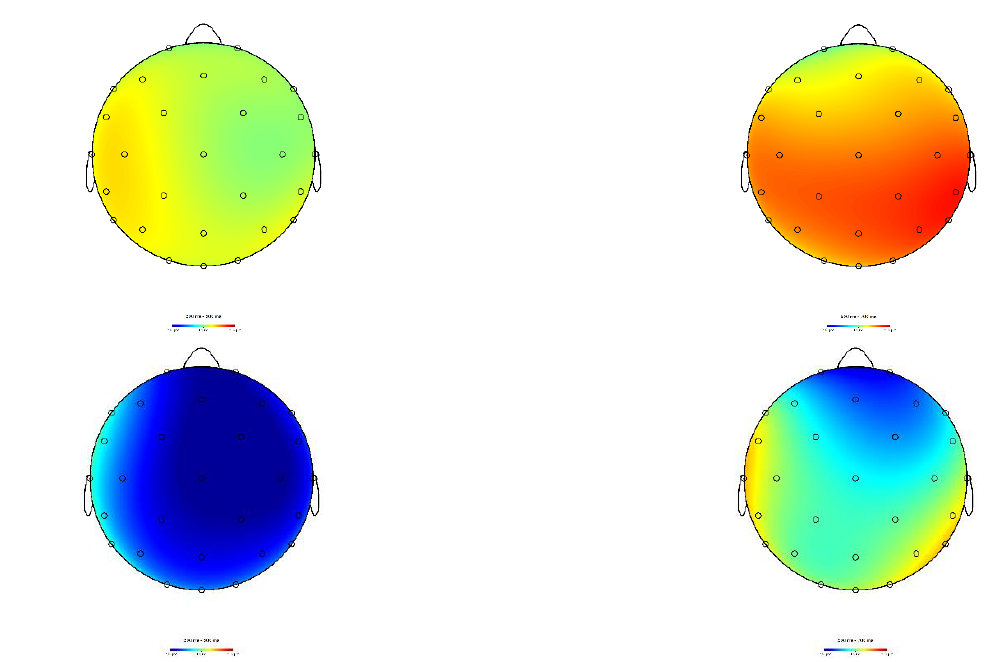
Figure 3. Scalp maps of relatedness effects (voltage differences were computed by subtracting the related from the unrelated condition) averaged across the N400 and the LPC time windows in Experiment 1 (upper row, the form condition and lower row, the semantic condition). Scale from − 2.5 μ V (blue) to 2.5 μ V (red).